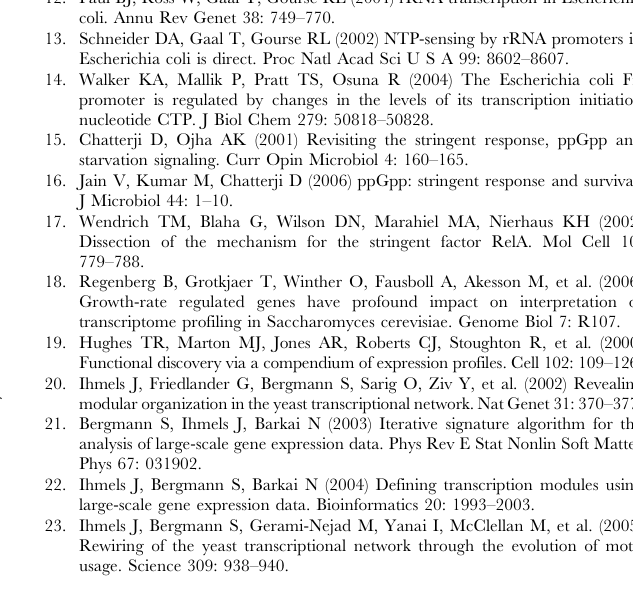
Figure S1 Growth curves of adh1 and wild type cells